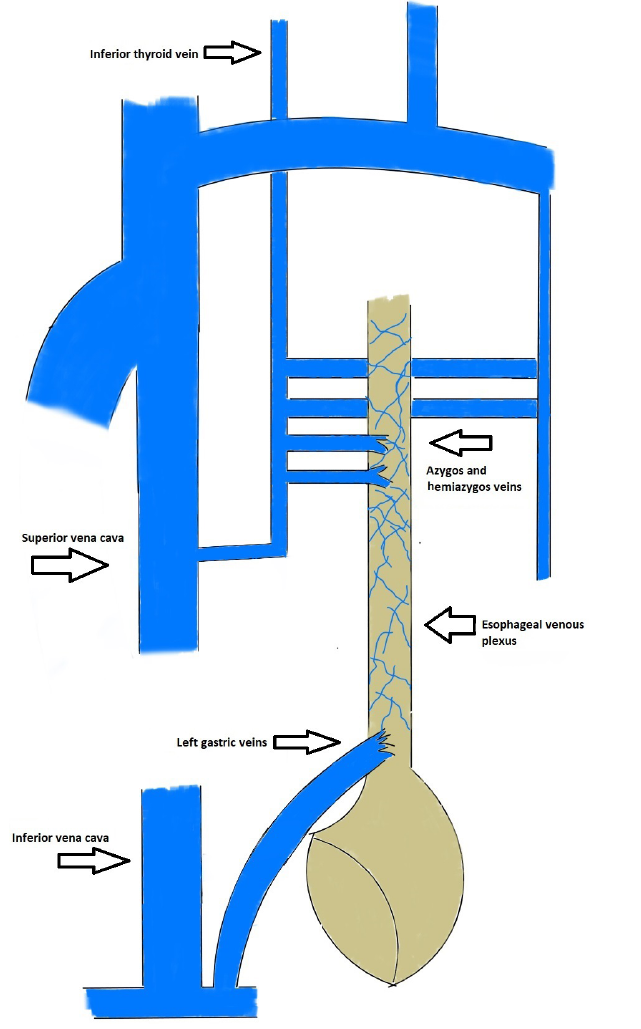
Figure 1. A demonstration of major venous return for